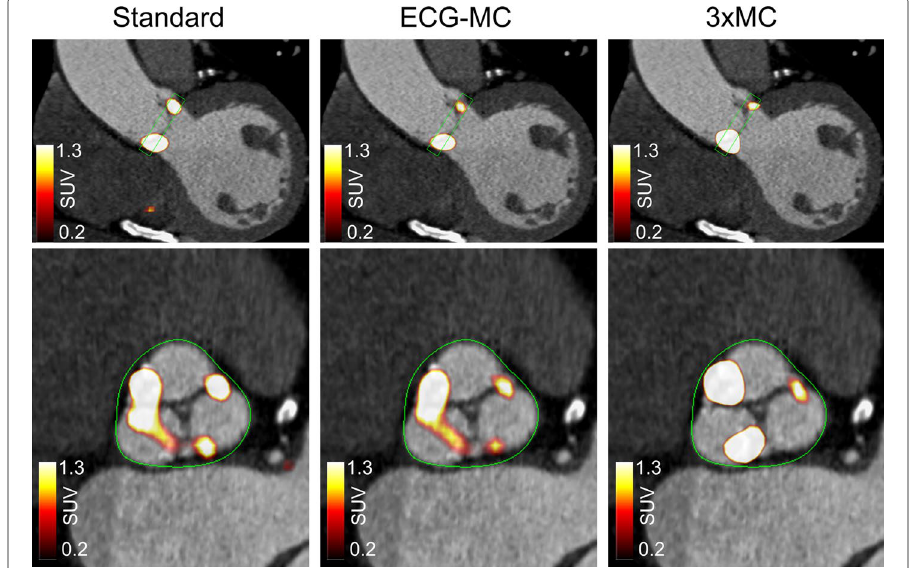
Fig. 2 Segmentation of the aortic valve used for quantification of 18 F-NaF uptake (shown as a green polyhedron). The valve was segmented on the end-diastolic image enclosing on the SUV max observed in the image to ensure high test–retest repeatability. Top row shows the coronal view of the myocardium, while the lower row represents the short-axis view of the aortic valve. ECG-MC